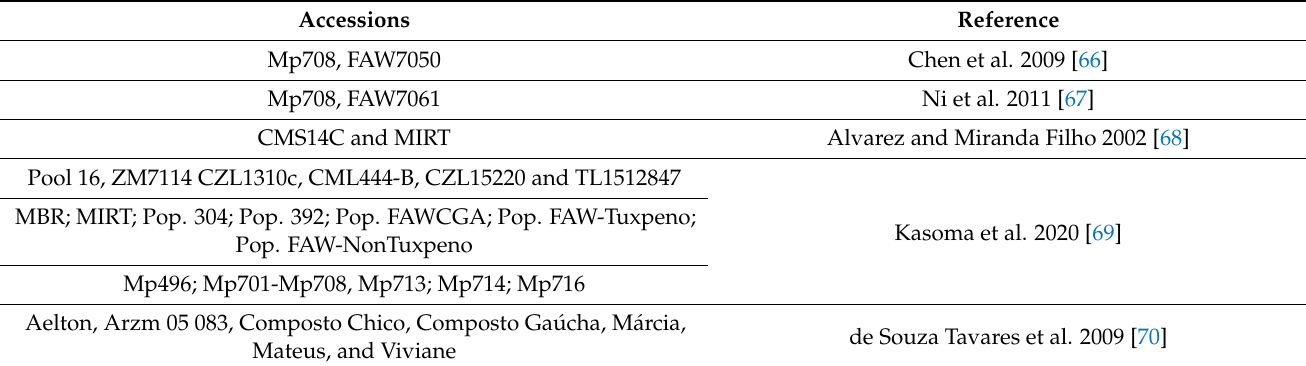
Table 1. Maize and sorghum germplasm showed resistance to fall